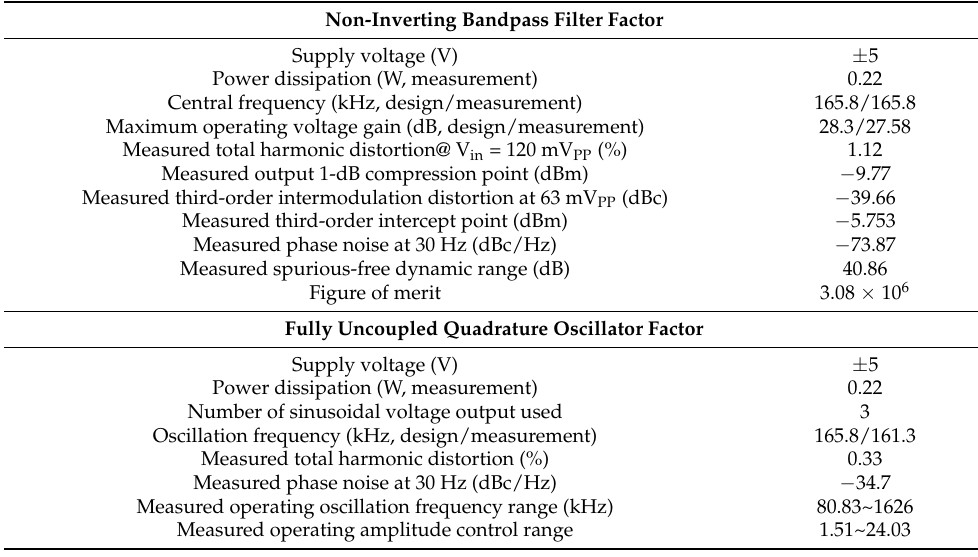
Figure 47. The experimental results of the V o6 voltage gain when R 5 was varied. Table 5. Performance parameters of the performance of the second proposed isomorphic